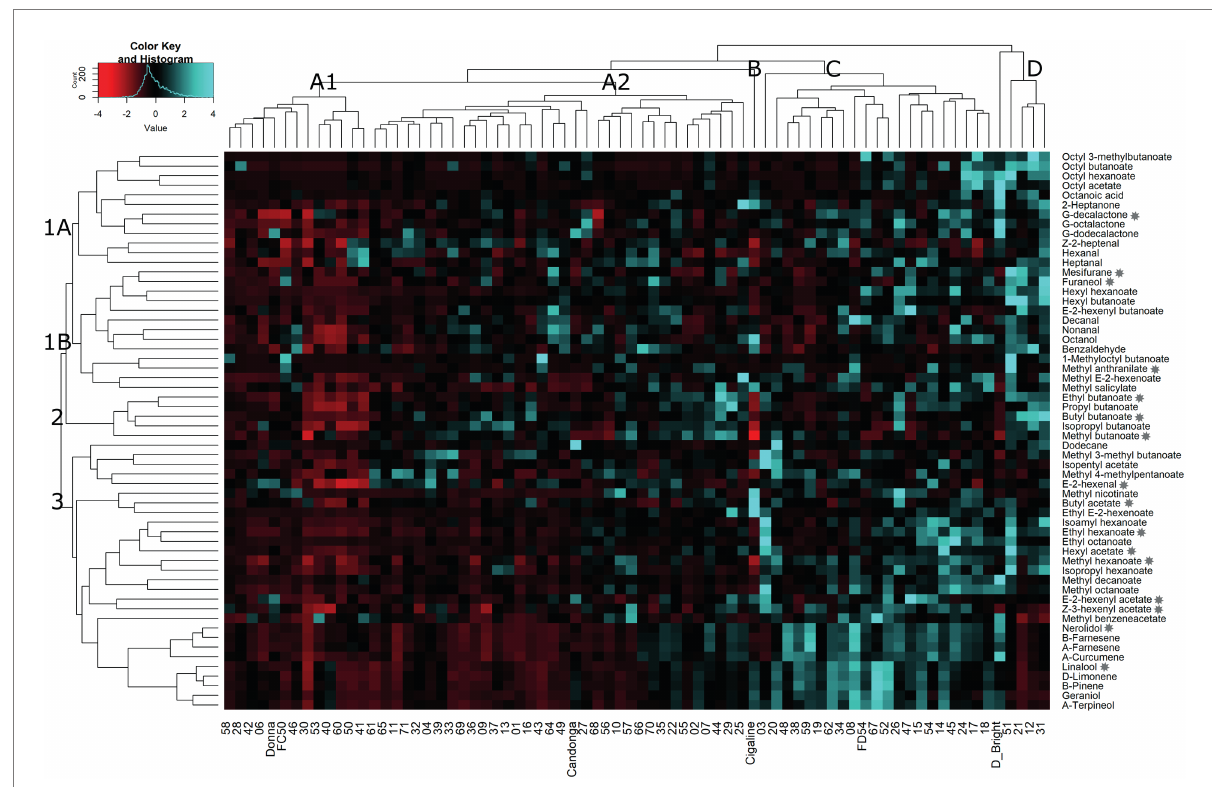
FIGURE 2 Heatmap representation of hierarchical clustering analyses (HCA) in VOCs in the “FC50 × FD54” population. Clusters are named by capital letters for individuals and numbers for VOCs. Stars indicate